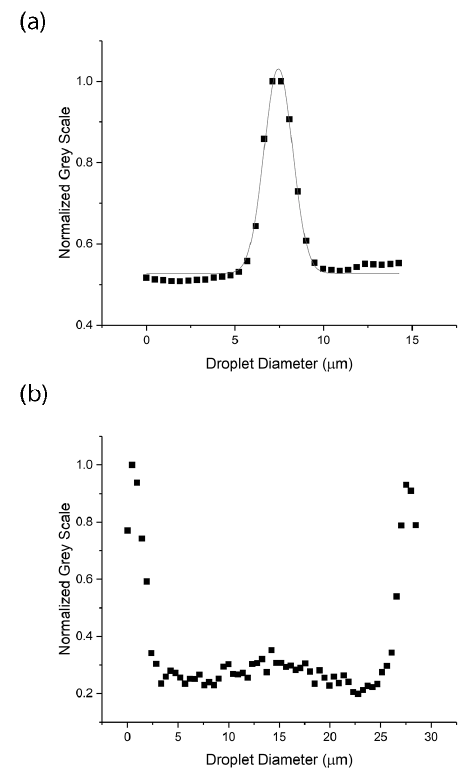
Figure 5 . Fluorescence intensity measurements across quantum dot clusters in a droplet as determined using a one-dimensional (1D) line profile across the microscope image. ( a ) Radial droplet example measured across the central cluster (as shown in Figure 1a) showing a peak intensity at the center of a droplet with Gaussian fit. ( b ) Similar data for a bipolar droplet measured across the surface clusters (as shown in Figure 1c) showing two peak intensities at opposite poles of the droplet.